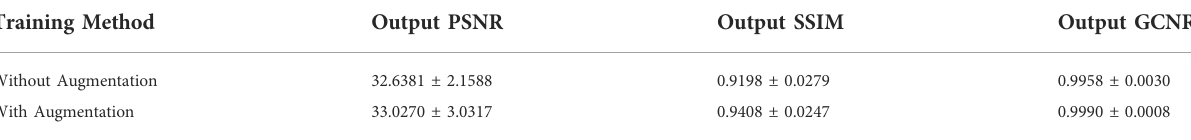
TABLE2PSNR,SSIM,andGCNRresultfor theablationstudyonthe effectofUSimageformationphysicsinformed dataaugmentation.(InputPSNR= 32.1392 ± 2.7026, Input SSIM = 0.9279 ± 0.0252, Input GCNR = 0.9974 ± 0.0017). Training Method